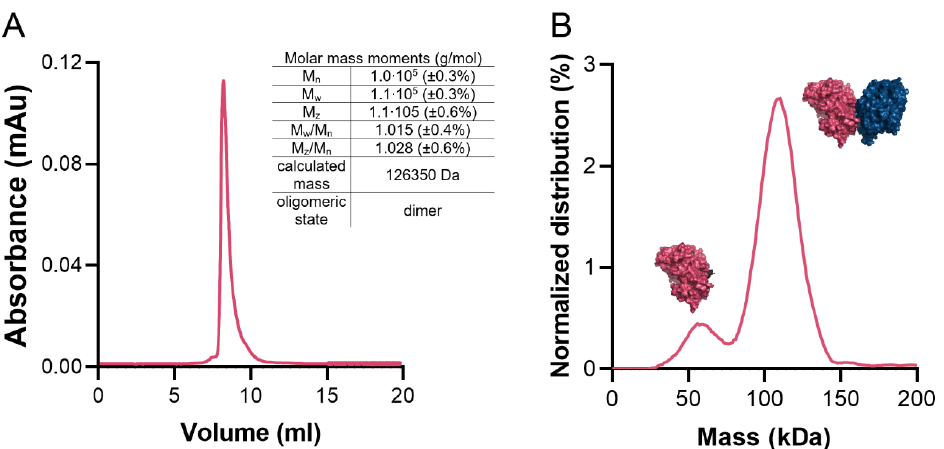
Figure 6. CtGK oligomeric state in solution. ( A ) Size-exclusion chromatography (SEC) elution profile